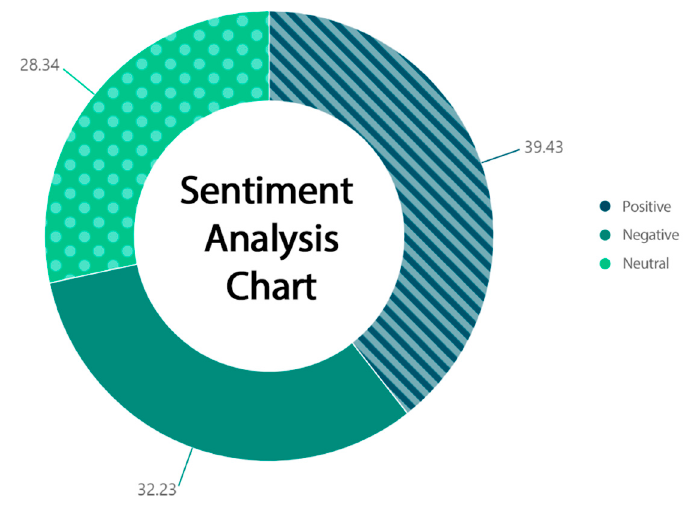
Figure 8. Sentiment analysis chart (before the outbreak).